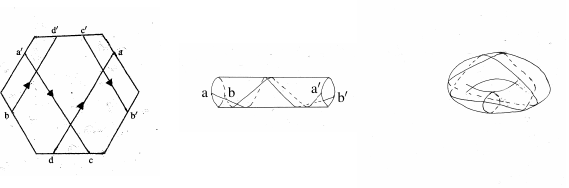
Figure 13. ( left ) A billiard motion in K ∗ = K ∗ which results in motion on a cylinder. ( right ) After identifying the points a , a (cid:48) and b , b (cid:48) on the cylinder the motion becomes a periodic geodesic on